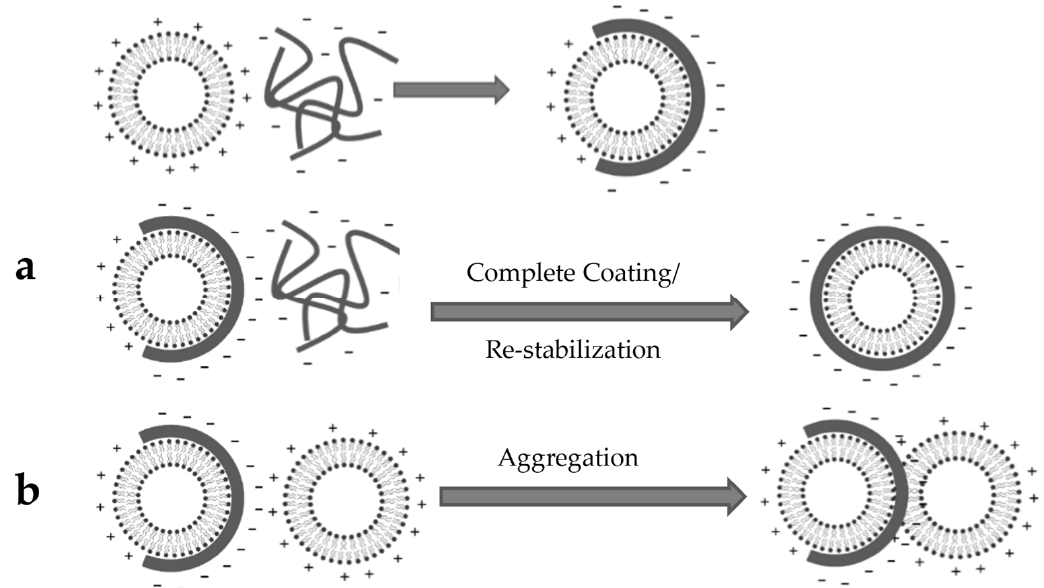
Figure 10. Schematic diagram of the interaction between the liposomes and ES100. The fate of interaction can either end with ( a ) complete coating, charge reversal, and restabilization, ( b ) or be interrupted by aggregation.